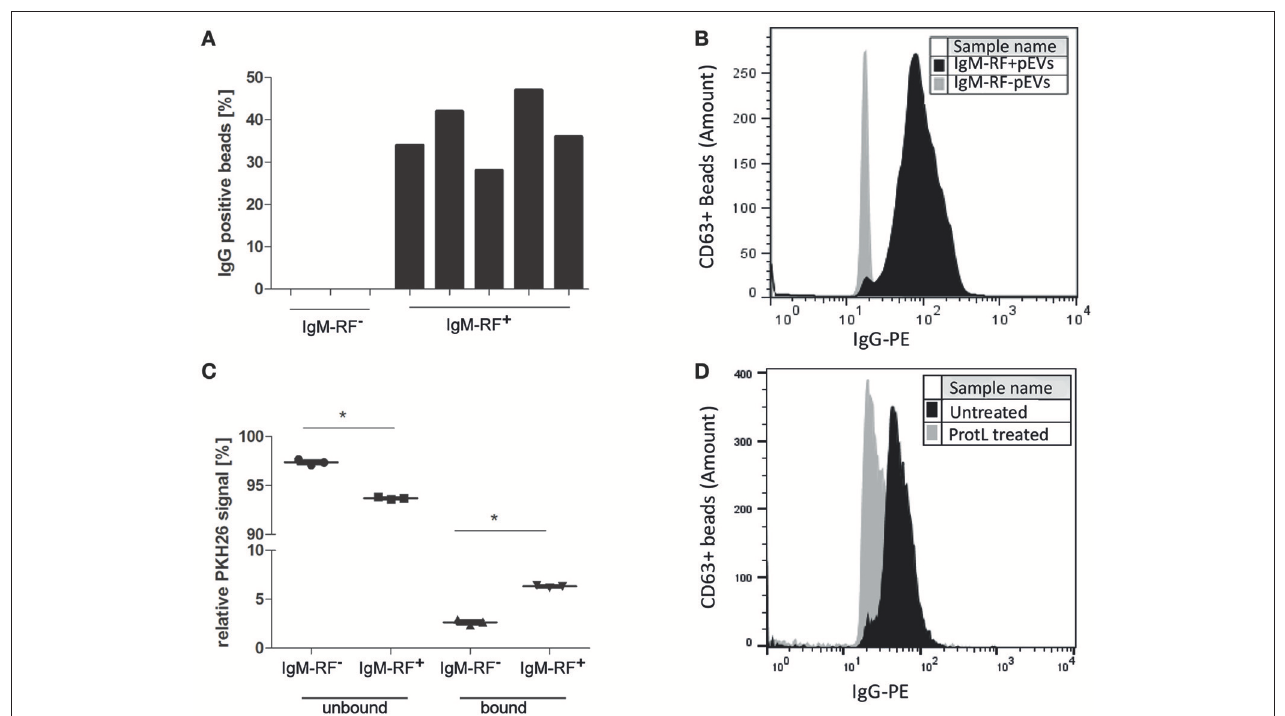
FIGURE 5 | Antibody (IgG) binding to IgM-RF containing pEVs. SEC fraction 5 of 8 RA patients were incubated to anti-CD63 beads to specifically immobilize the EVs to the beads. Thereafter, the beads were incubated with human IgG-PE and analyzed by FC. IgG binding to pEVs coupled to anti-CD63 magnetic beads was only found in the RF + RA patients with IgM-RF + pEVs (A) . A representative FC plot is shown of a RF + RA patients with IgM-RF + pEVs (black) and RF + RA patients with IgM-RF − pEVs (gray) (B) . (A,B) showed a IgG binding factor on pEVs. Next pEVs were stained by PKH26 and incubated with protein-L beads. The level of bound and